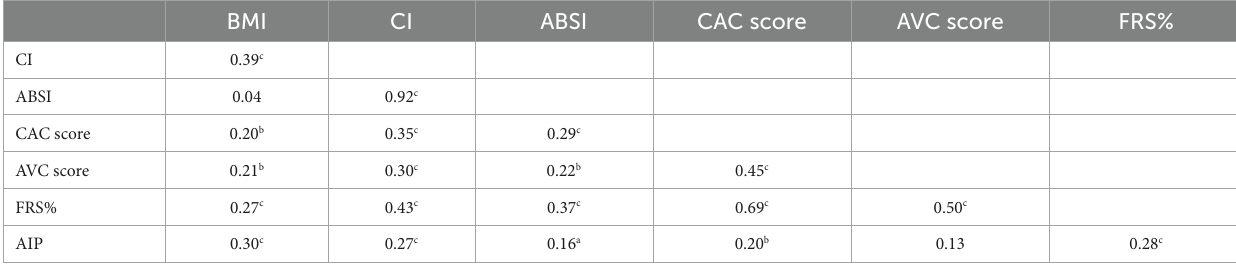
TABLE 4 Multivariate linear regression analysis of parameters related to conicity index (CI) and a-body shape index (ABSI) in CKD5 patients. CI (adj r 2 = 0.18) ABSI (adj r 2 = 0.10)